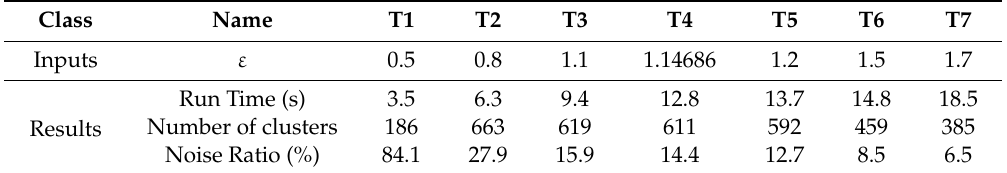
Table 5. The segmentation results using different thresholds for mobile laser scanning data from X , Y , Z fields.